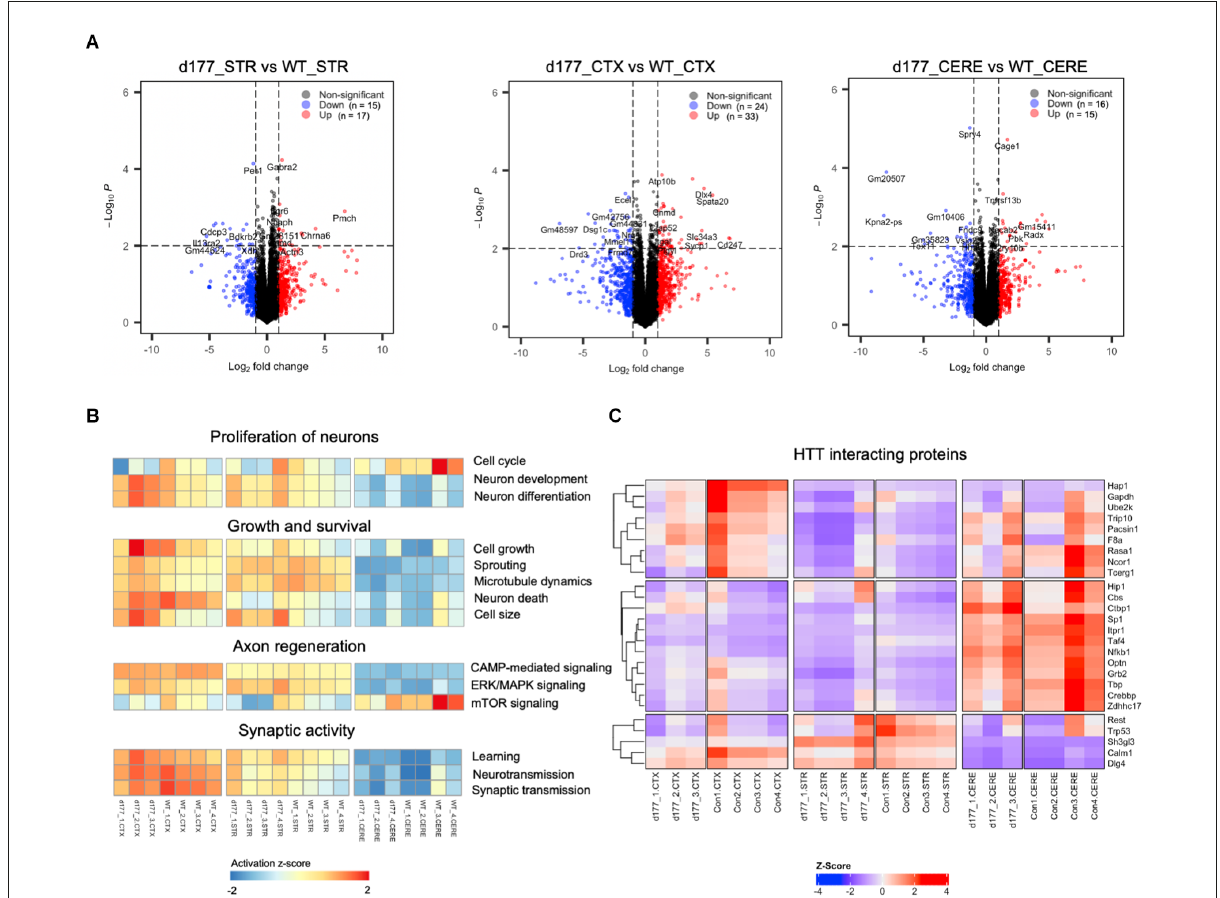
FIGURE5 Comparison of gene expression in D177 and wild type mouse brain. (A) The volcano plot of DEGs (adjust. P -value < 0.05, |fold change| >1.0) in the striatum, cortex, and cerebellum between D177 and WT mice. Red dots indicate up-regulated genes, and blue dots indicate down-regulated genes. (B) Gene set variation analysis (GSVA) results suggests that there are few differences between D177 and WT mice in four neuron associated pathway sets. Red indicates pathway activation; blue indicates pathway inhibition. (C) The heatmap of HTT directly binding protein expression matrix, the majority of genes show similar mRNA expression levels in the cortex, striatum, and cerebellum between D177 and WT